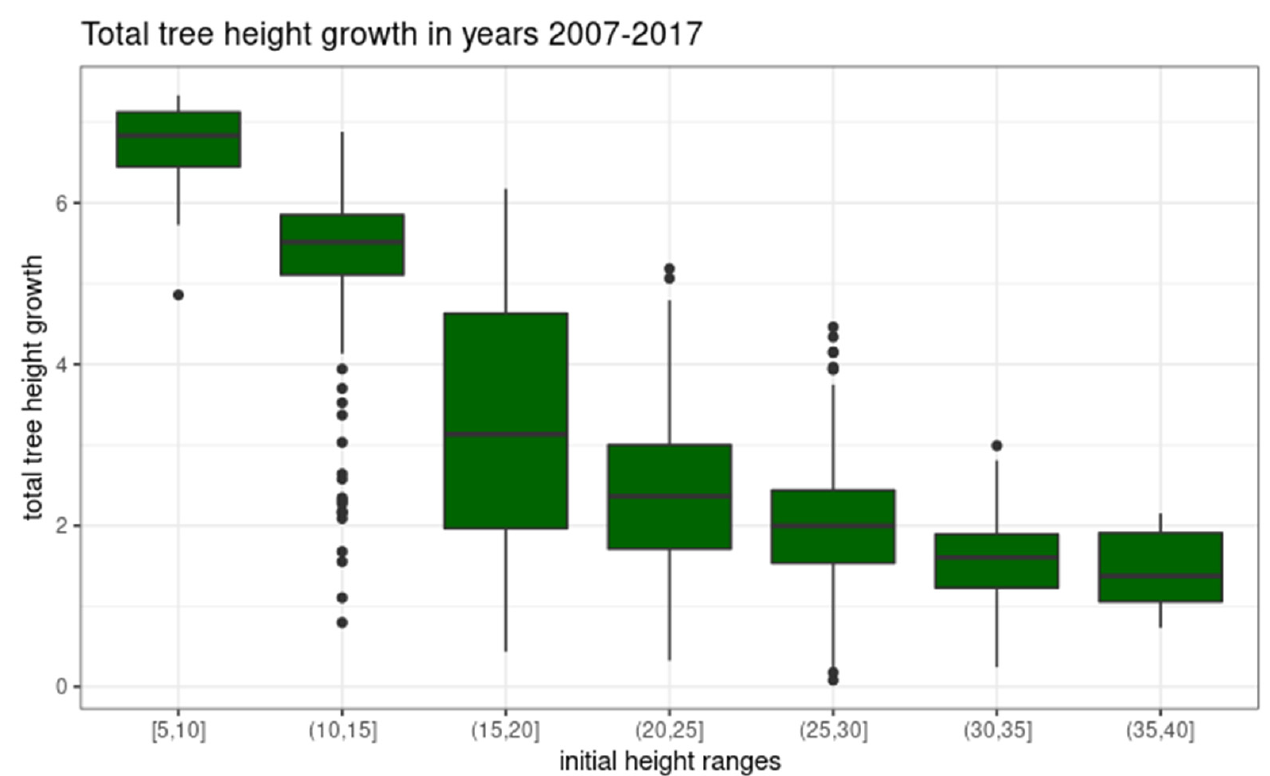
Figure 12. Distributions of ten years (2007–2017) of height growth of Scots pine trees in different initial height ranges.